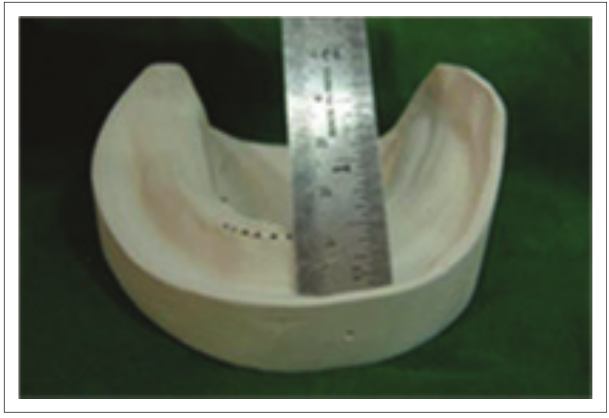
FIGURE 2: Positive cast made out of plaster of Paris (POP).